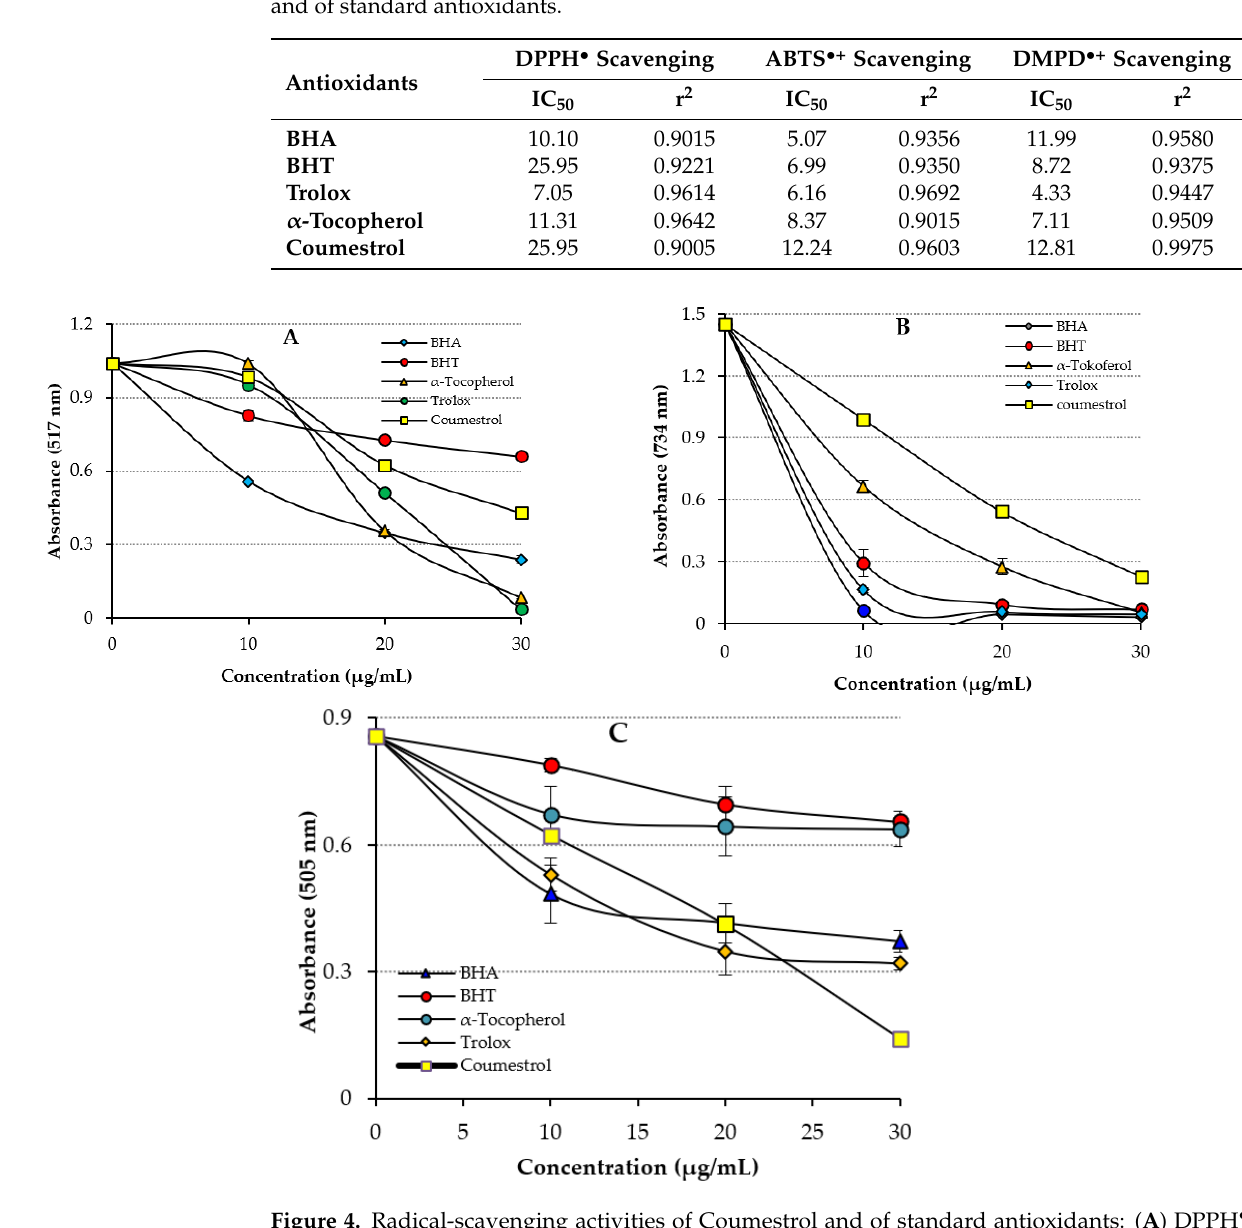
Figure 4. Radical ‐ scavenging activities of Coumestrol and of standard antioxidants: ( A ) DPPH • ‐ scavenging, ( B ) ABTS •+ ‐ scavenging, and ( C ) DMPD •+ ‐ scavenging